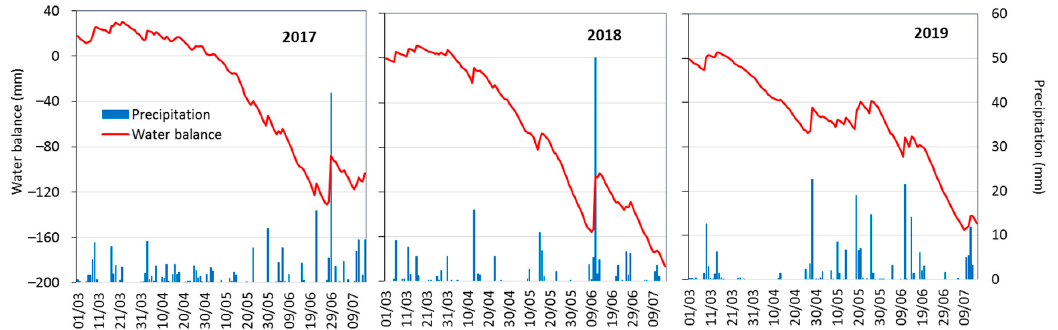
Figure 2. Precipitation and water balance (precipitation minus evapotranspiration) in the years 2017– 2019 in Brandýs n. Labem (near Sojovice).